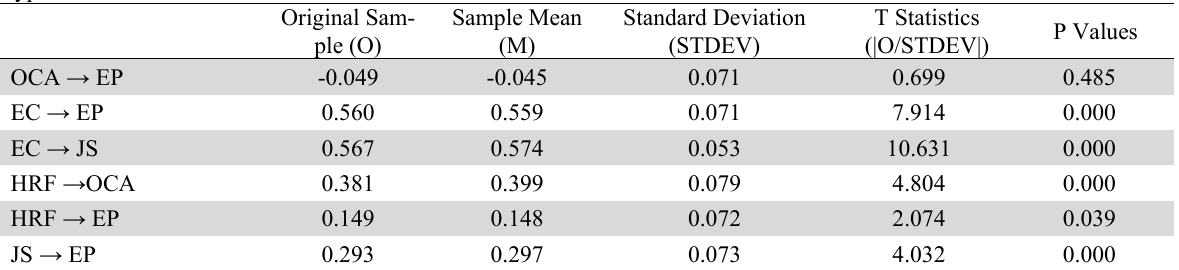
Hypothesis test results for direct influence